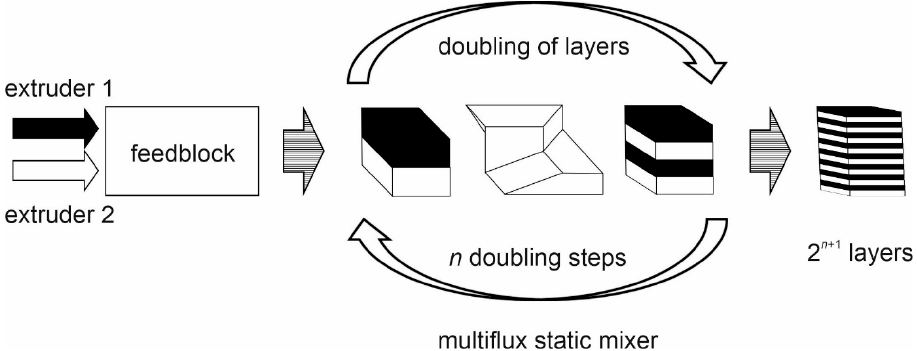
Figure A1. Multilayer extrusion using a multiflux static mixer, adapted from